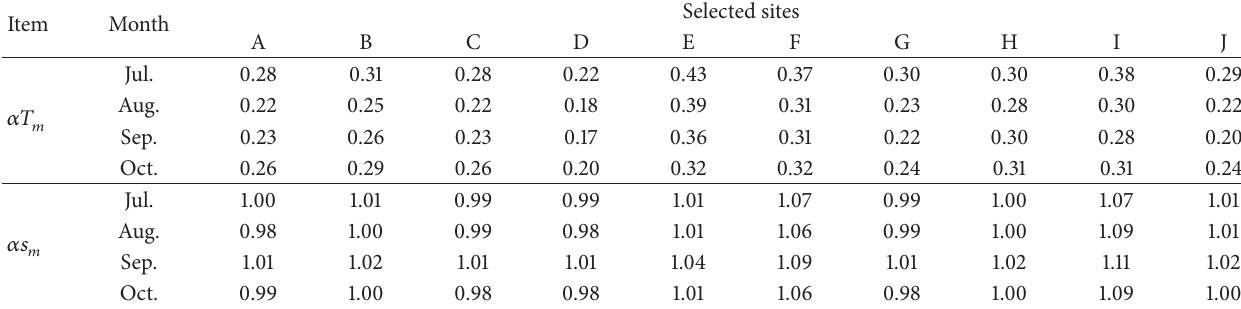
Table 3: Values of 𝛼𝑇 𝑚 and 𝛼𝑠 𝑚 , for the morphing